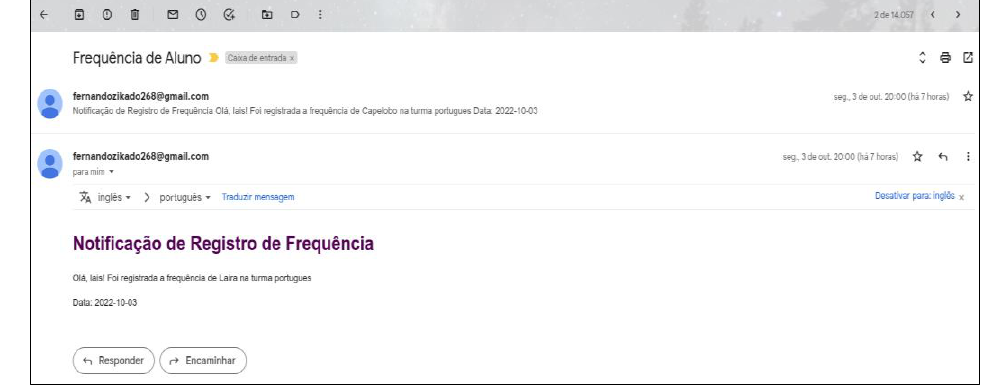
Figure 8: Frequency